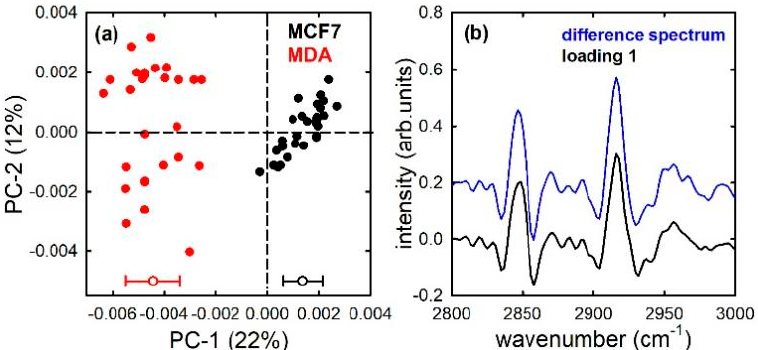
Figure 5. PC1 and PC2 score plot ( a ) for the MCF7 (black dots) and MDA (red dots) cells; average (+0.0014 and − 0.0044 for MCF7 and MDA, respectively) and standard deviation (0.0008 and 0.0011 for MCF7 and MDA, respectively) of the PC 1 distribution values are shown at the bottom of ( a ). Loading 1 spectrum (black line), compared with the difference between average spectra (blue line), is reported in ( b ).